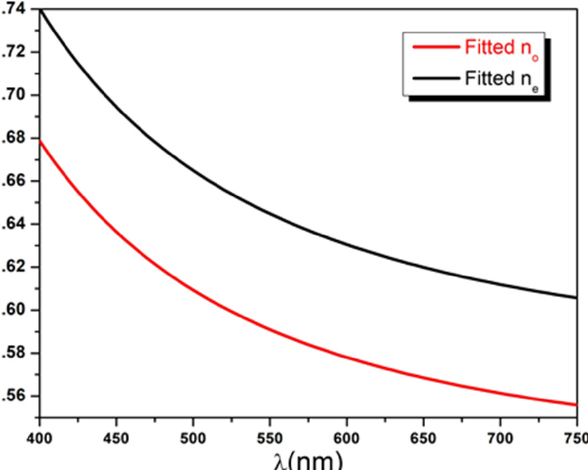
Figure 10. Ordinary and extraordinary refractive indices dispersion curves calculated using Cauchy model and the best fit parameters.